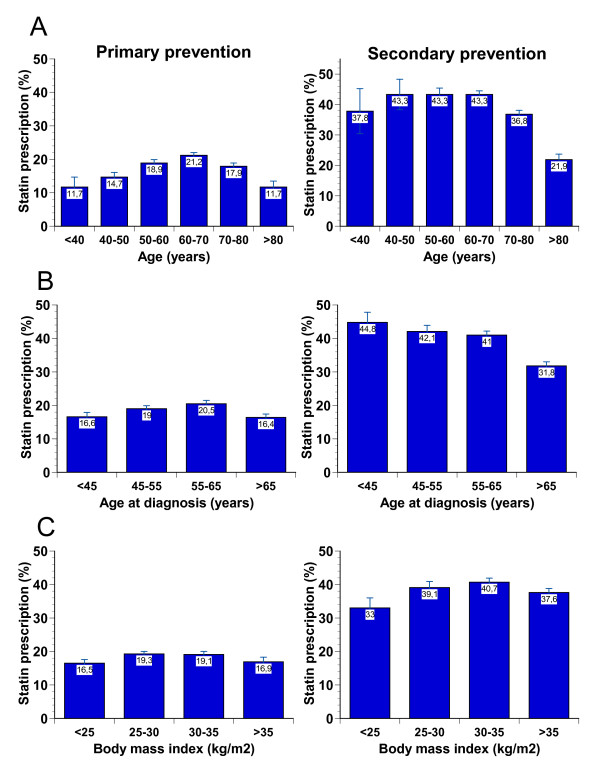
Unadjusted statin prescription frequencies according to age (A), age at diagnosis of diabetes (B), and body mass index (C). Primary prevention data are shown on the left and secondary prevention on the right side. Data are proportions (%) and 95% confidence intervals for binomial distributions.